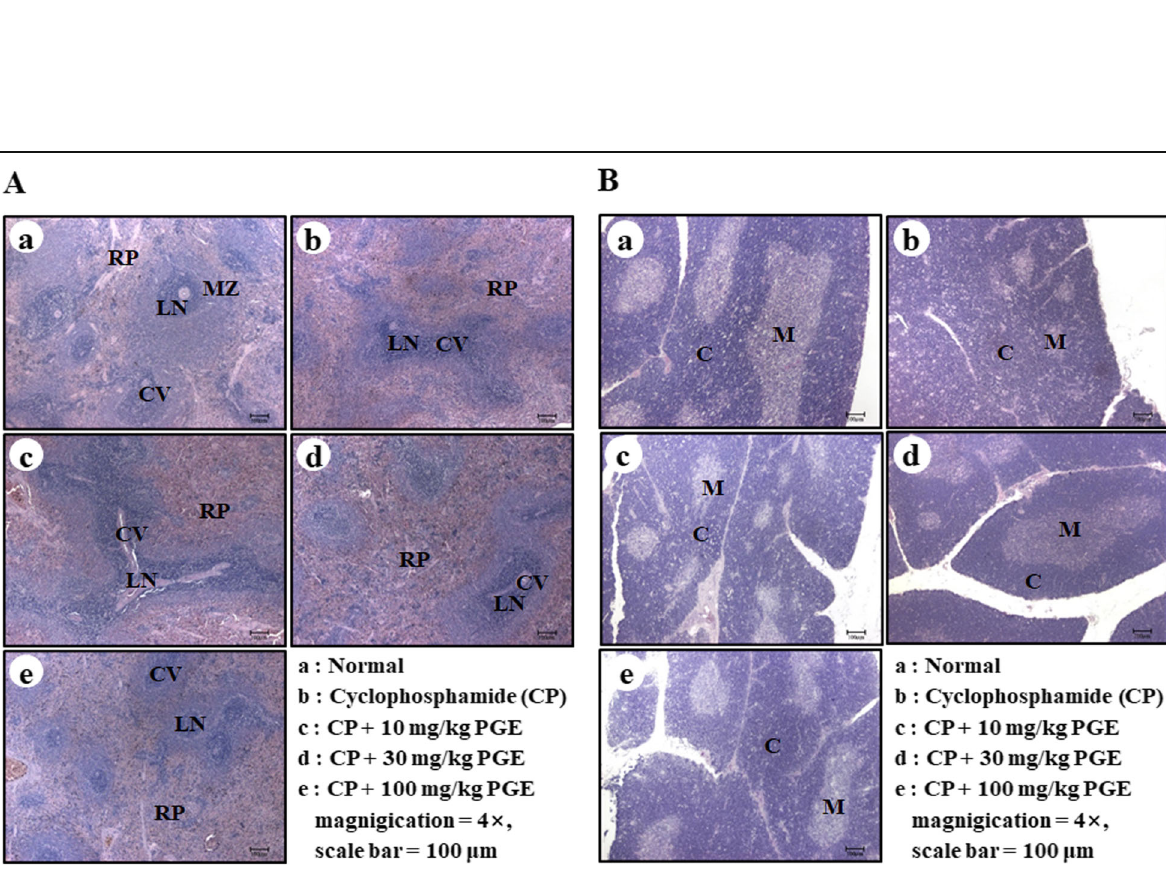
Fig. 9 Effect of PGE on immunity-associated spleen and thymus damage in CP-induced immunosuppressed rats. Rats were given saline, CP (5 mg/kg/day), and PGE (0, 10, 30, or 100 mg/kg/day) once daily for 28 days, after which damage in the spleen ( a ) and thymus ( b ) was analyzed histologically. Representative images of the sectioned spleens of ( a ) normal rats (saline treatment), ( b ) control rats (treated with only CP), and ( c – e ) CP and PGE-treated rats [( c ) 10 mg/kg, ( d ) 30 mg/kg, or ( e ) 100 mg/kg PGE]. Scale bar = 100 μ m. CV, central vein; LN, lymph nodule; MZ, marginal zone; RP, red pulp; C, cortex; M,